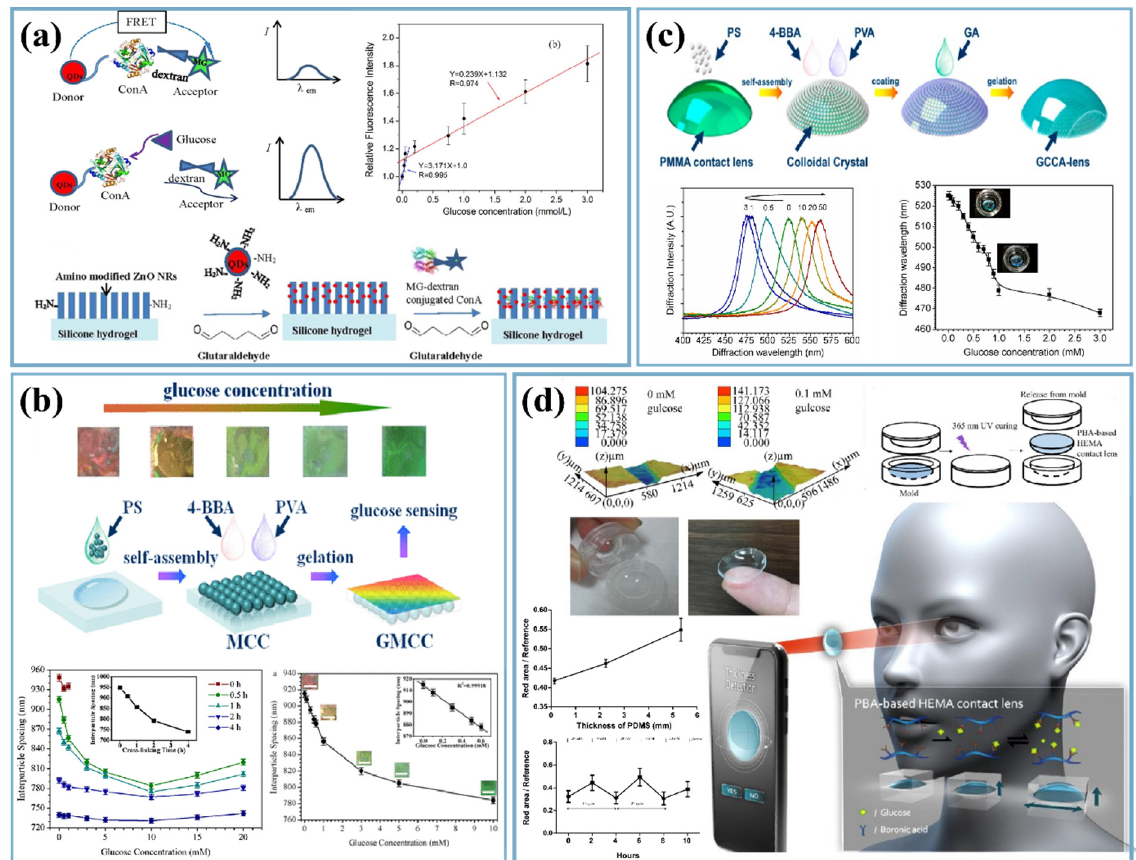
Figure 5. ( a ) Working principle behind designed FRET transducer in detecting glucose. (Reproduced with permission from Chen et al., Biosens. Bioelectron., vol. 91, pp. 393–399, 2016 [72]. Copyright 2016, Elsevier Ltd.) ( b ) Construction of gelated monolayered colloidal crystal (GMCC) 2D structure and its color correlation with glucose content. (Reproduced with permission from Chen et al., 2018 [74]. Copyright 2018, American Chemical Society.) ( c ) The process for preparation of the 4-BBA-PVA GCCA-lens. (Reproduced with permission from Ruan et al., Polymers, vol. 9, no. 125, pp. 1–12, 2017 [76]. Copyright 2017, authors under open access licenses.) ( d ) Portable non-invasive contact lens with an imaging program in a smartphone and the mechanism involved. (Reproduced with permission from Lin et al., Sensors, vol. 18, no. 10, Sep. 2018 [77]. Copyright 2018, authors under open access licenses.)